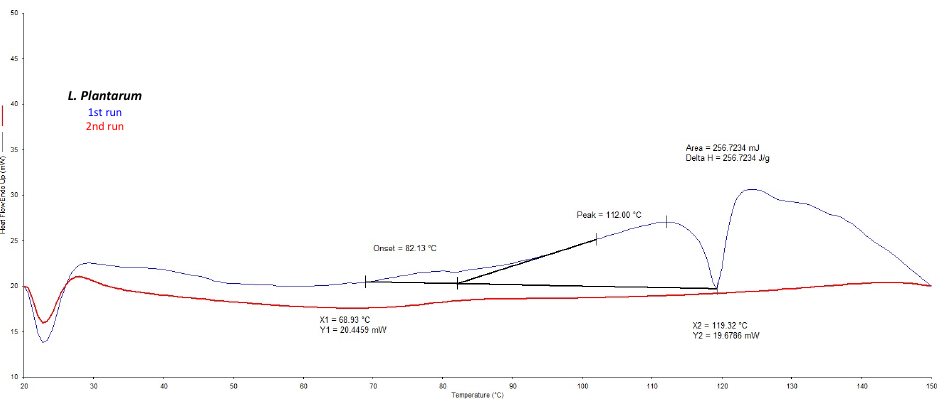
Figure 1. DSC curves of the first (blue) and second (red) run of L. plantarum thermal profile.